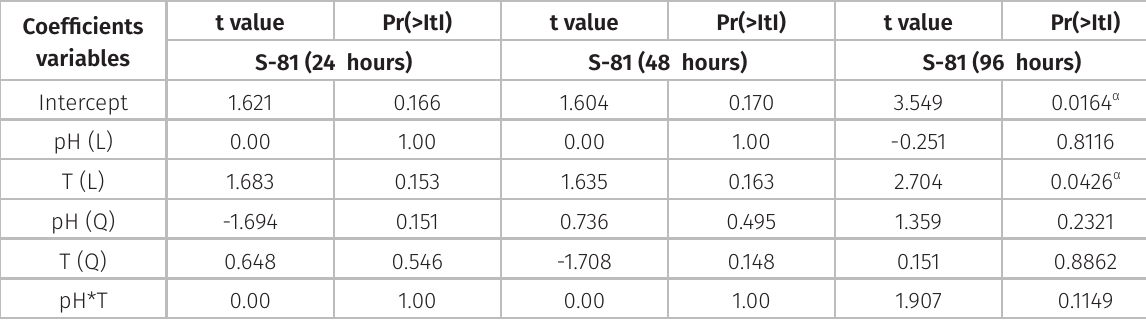
Table IV. Main effect (t-value) and p-value of pH and temperature for S-81 Candida homilentoma , using CCRD.